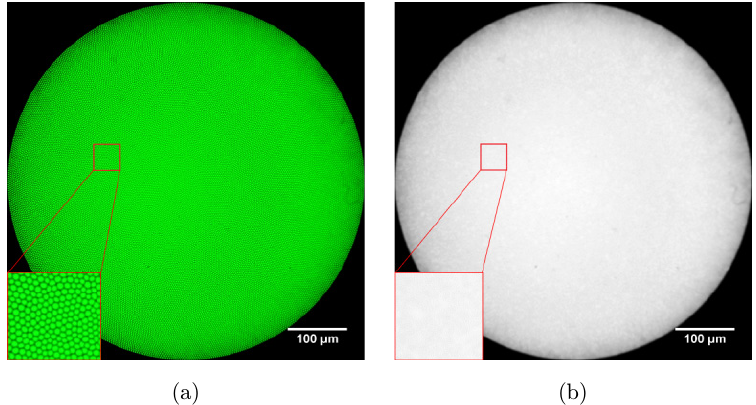
Fig. 2. Raw (a) and ¯ber pattern rejected (b) images of a uniform °uorescence reference slide.